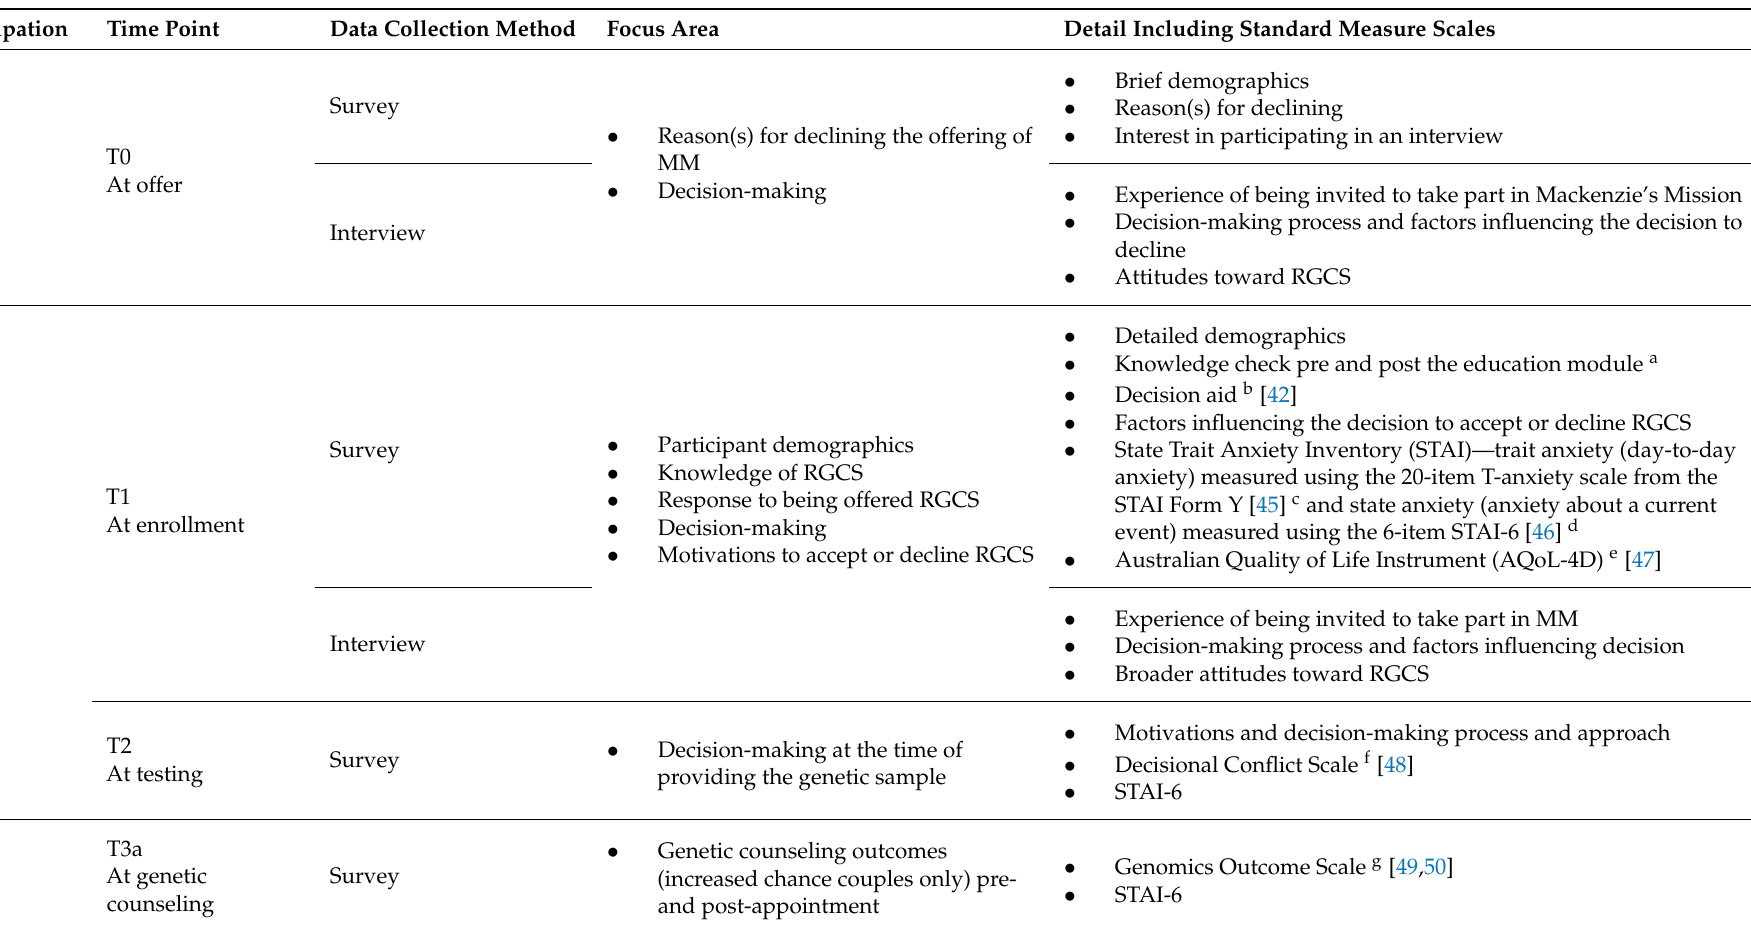
Table 3. Data collection for people offered reproductive genetic carrier screening in the Mackenzie’s Mission